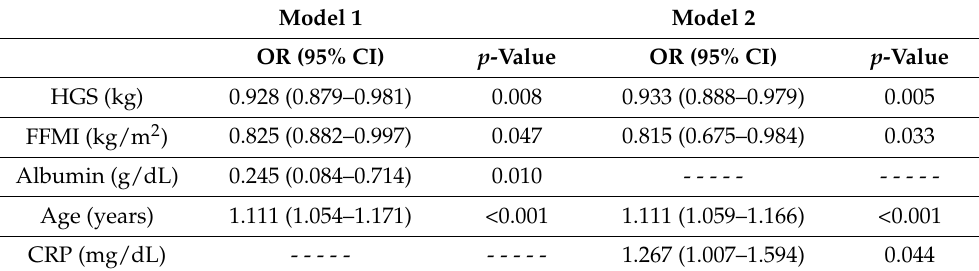
Table 5. Multivariate logistic